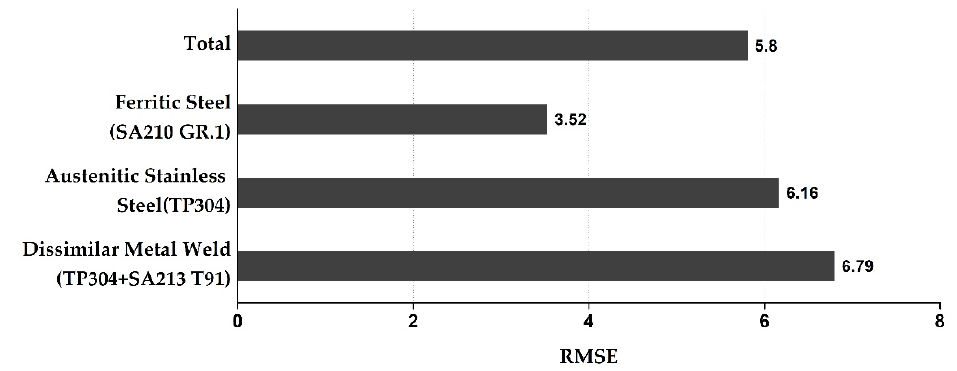
Figure 6. RMS result to evaluate the sizing accuracy according to the